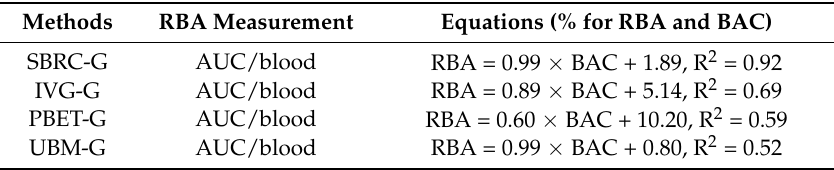
Table 1. Summarized in vitro-in vivo relations for arsenic